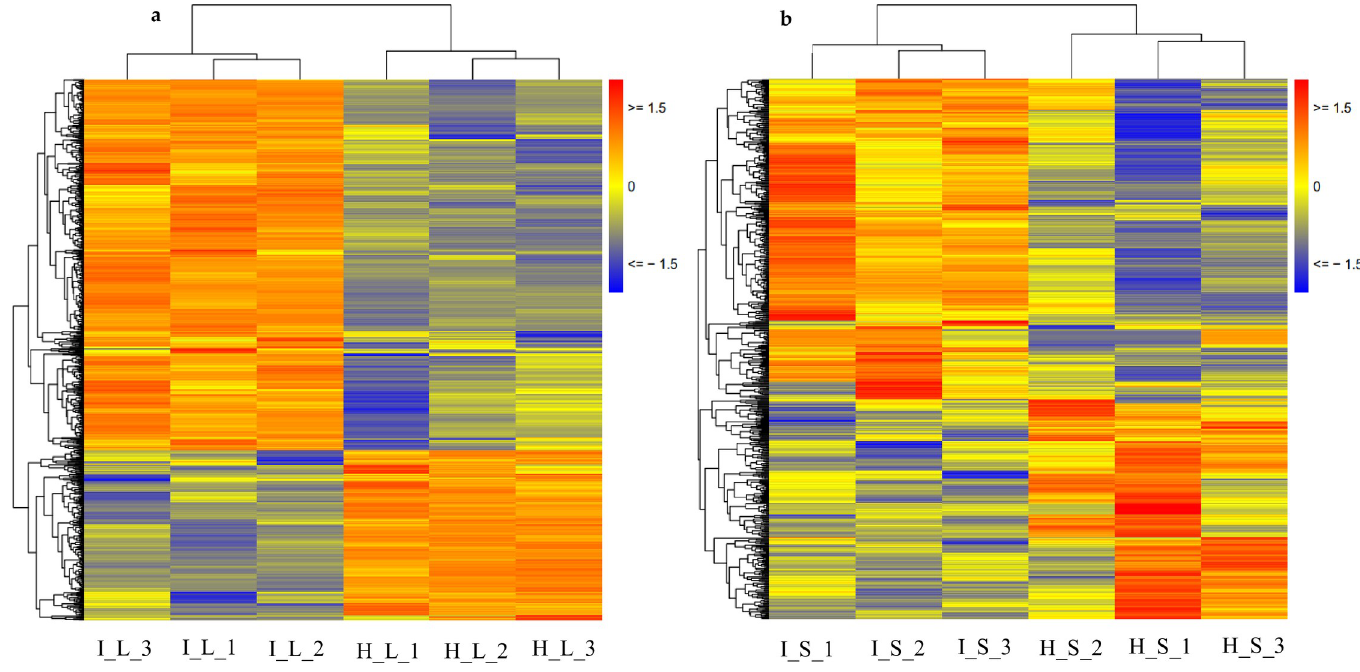
Fig 2. Heat map of all transcripts of (FPKM > 1) (a) sugarcane leaves; (b) sugarcane